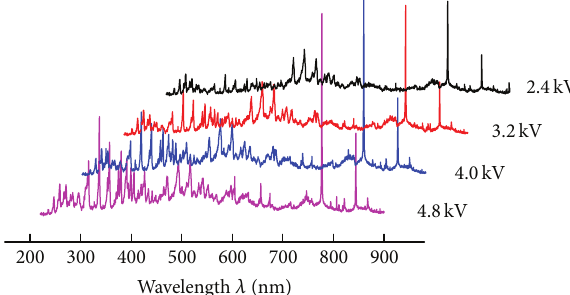
Figure 4: Emission spectra under different pulse voltage inputted from 2.4 to 4.8